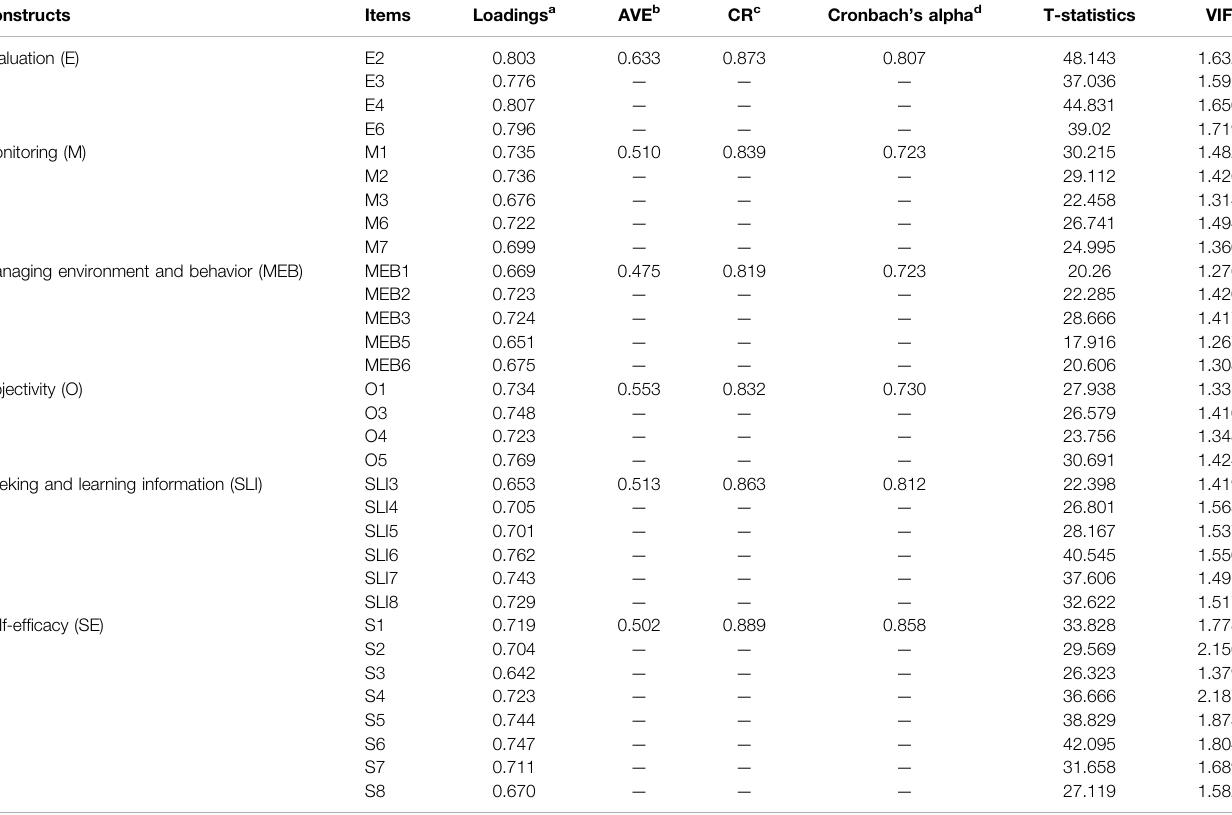
TABLE 2 | Summary of measurement models.